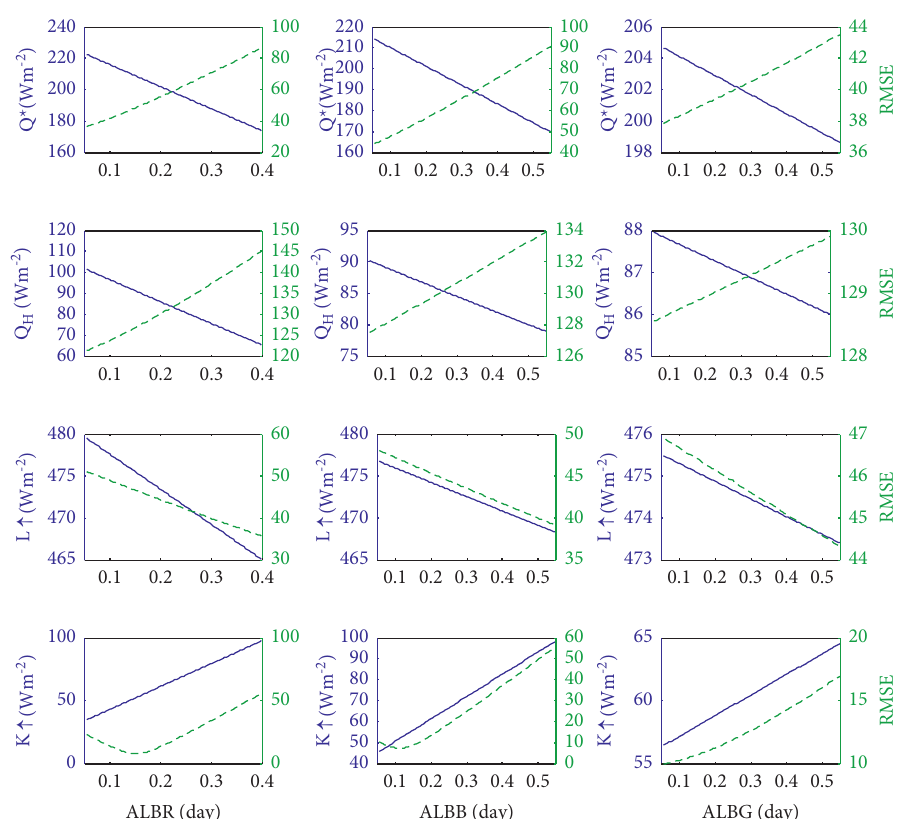
Figure 7: Variations of the mean (blue solid line) and RMSE (green dashed line) of the net all-wave radiation ( Q ∗ ), sensible heat flux ( Q upward longwave radiation (L ↑ ), and shortwave radiation (K ↑ ) with roof (ALBR), wall (ALBB), and road (ALBG) albedo parameters during